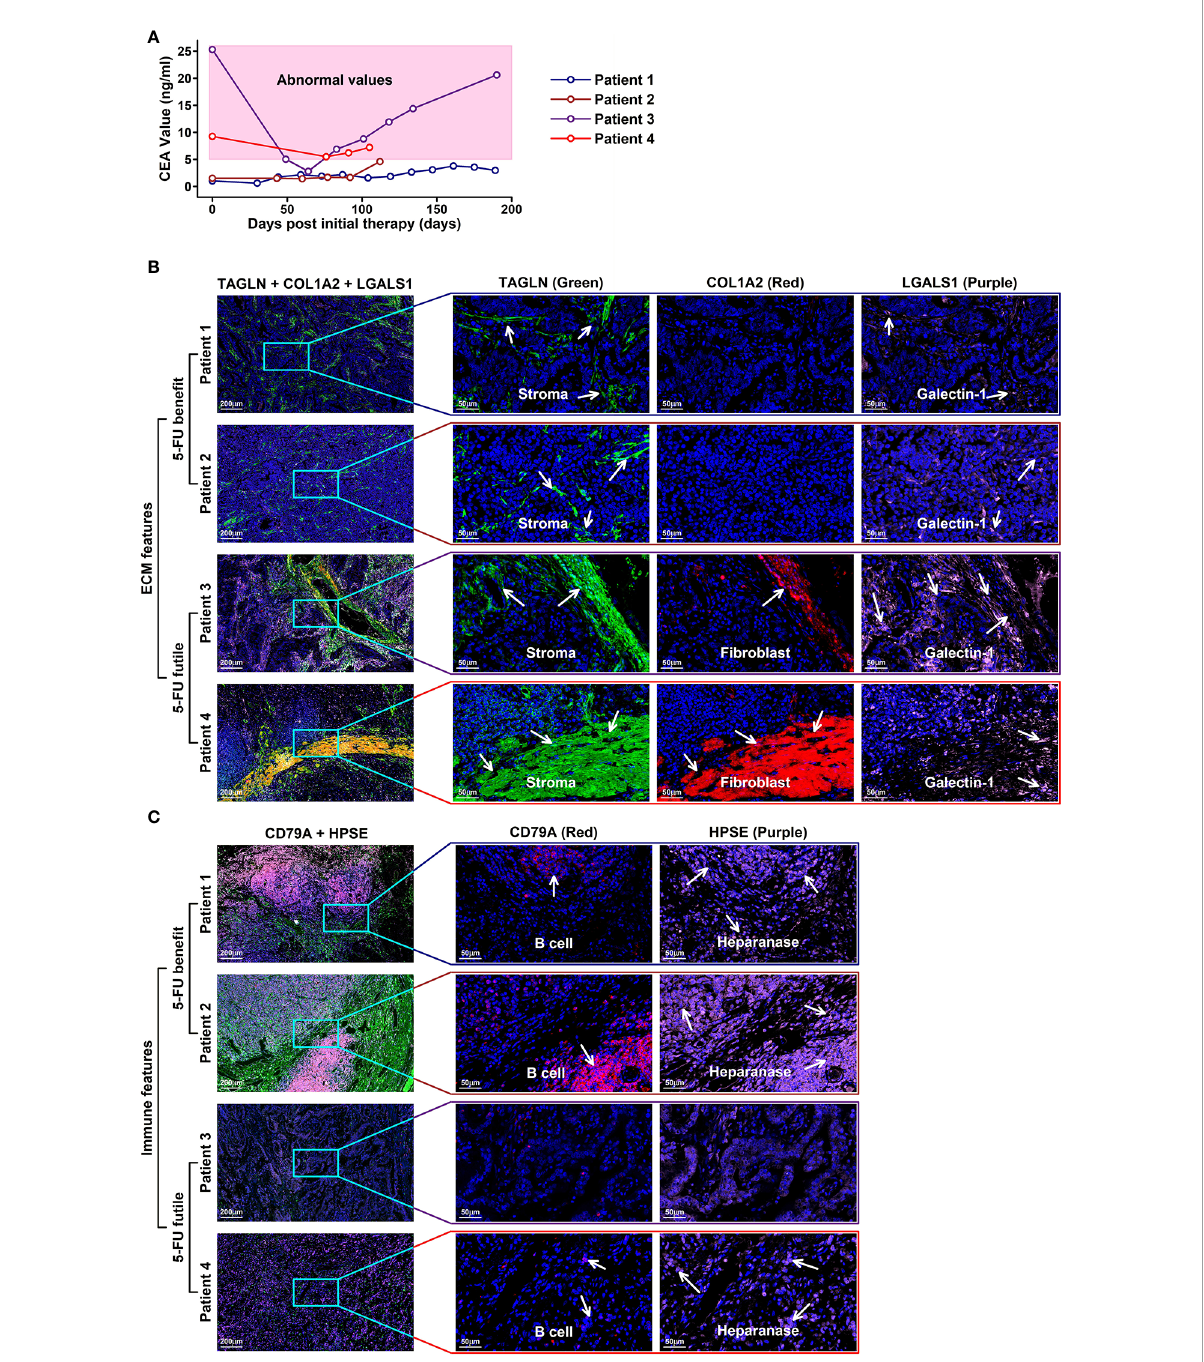
FIGURE 8 Immunostaining validation of TME features in 5-FU treated GC patients (A) CEA values of four GC patients with 5-FU chemotherapy treatments after radical gastrectomy; (B) ECM features in the tumor tissues of these four patients. Stroma cells are colored in green (TAGLN) and red (COL1A2); Galectin-1 is colored in purple (LGALS1). In 5-FU-bene fi t GC patients, more stroma cells as well as cells secreting galactin-1 are examined compared to those in 5-FU-futile GC patients. (C) Immune features in the tumor sections of these four patients. B cells are colored in red (CD79A); heparanase is colored in purple. In 5-FU-bene fi t GC patients, more B cells, as well as cells secreting heparanase are examined compared to those in 5-FU-futile GC